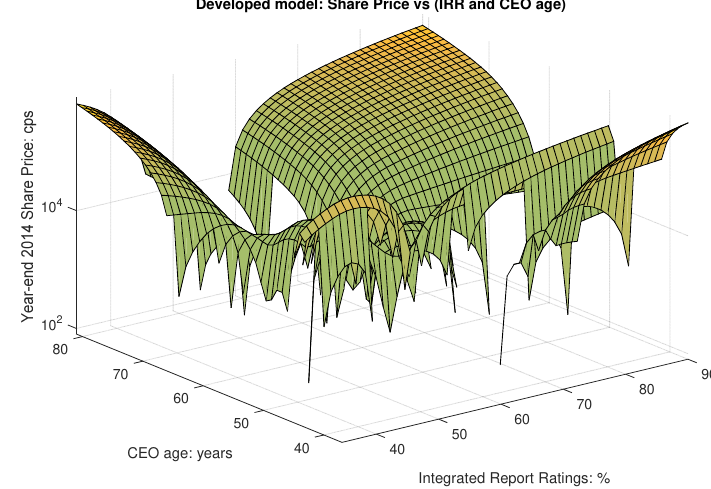
Fig. 7. Share price versus IRR & CEO age: Top-106 JSE listed